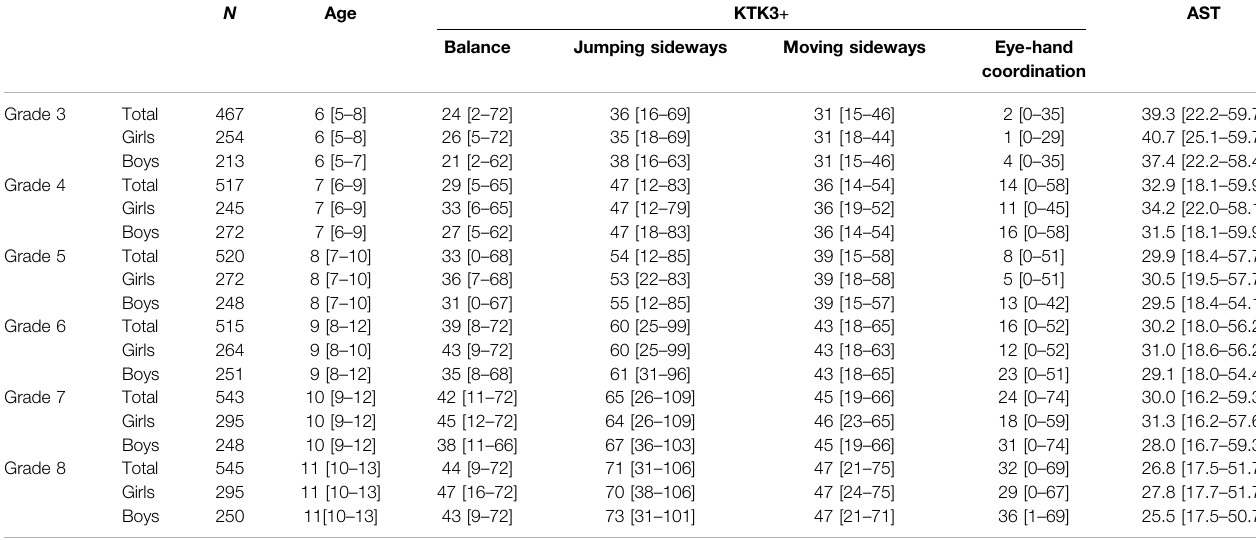
TABLE 2 | Pearson correlation coef fi cients between the KTK3+ and the AST.